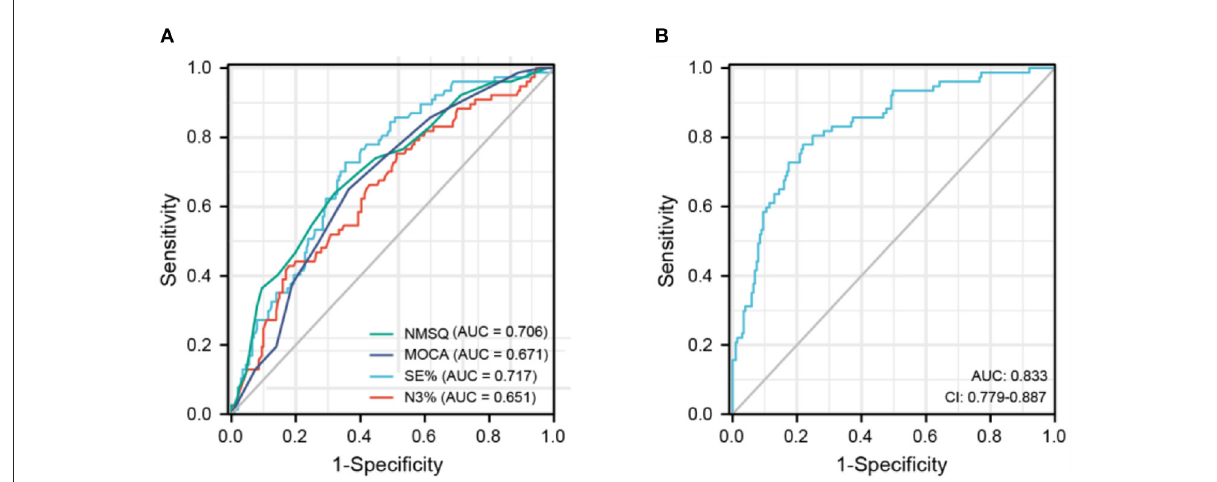
FIGURE1 Receiver operating characteristic curve of predicting hallucinations in Parkinson’s disease patients. (A) NMSQ score, MOCA score, SE%, N3% for independently predicting hallucinations occurrence in PD patients. (B) A combination of NMSQ score, MOCA score, SE%, N3% for predicting hallucinations occurrence in PD patients. AUC, area under the curve; MOCA, Montreal Cognitive Assessment; N3, non-REM sleep stage 3; NMSQ, Non-motor Symptoms Questionnaire; SE, sleep